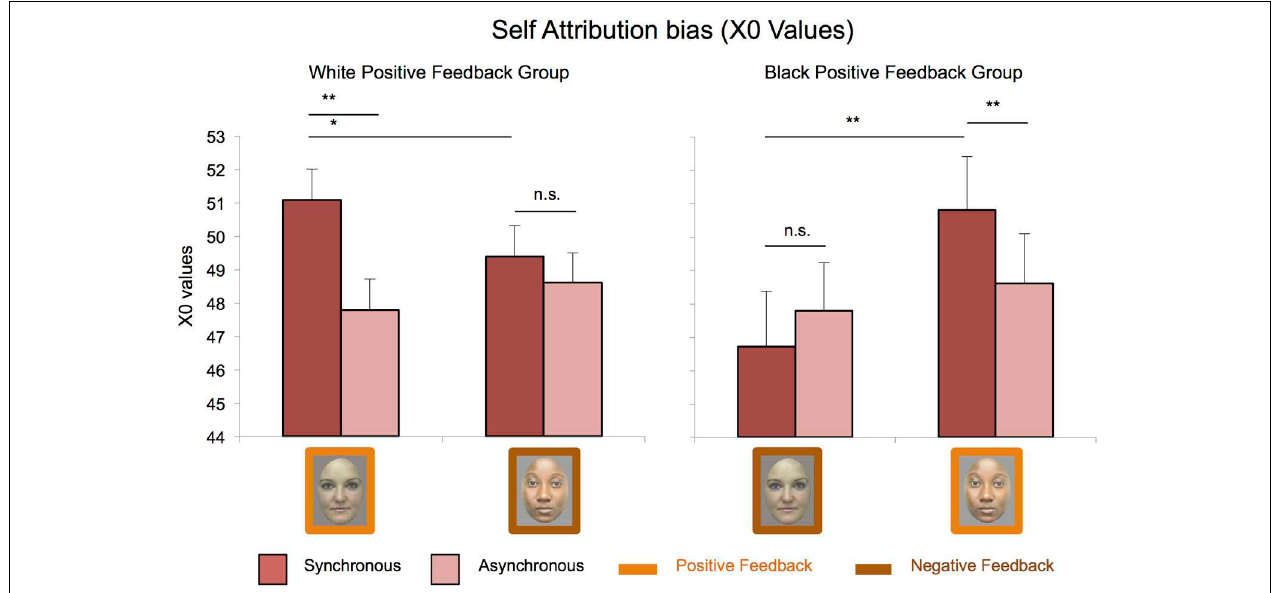
FIGURE 3 | Implicit measures of enfacement. At the implicit level, the illusion was present as indexed by higher self-attribution scores after the synchronous compared to the asynchronous condition only for liked partners independently of their group membership. Results